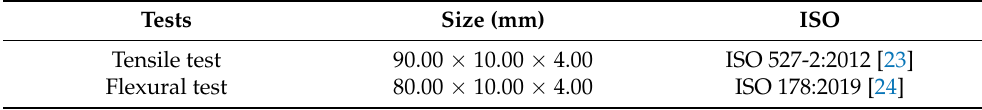
Table 3. Mechanical tests and standard